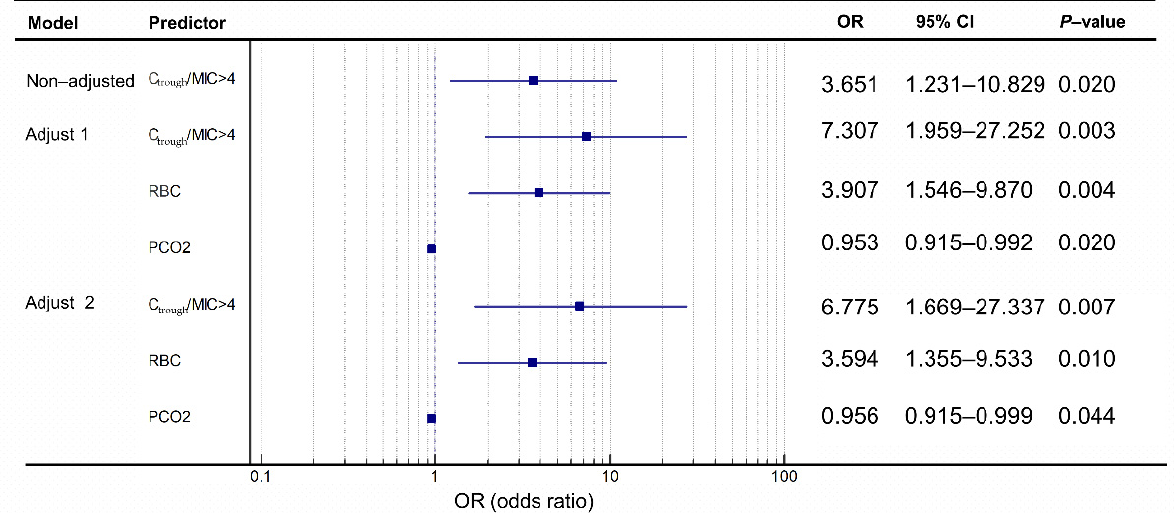
Figure 4. Forest plot of predictors of meropenem treatment success. OR, odds ratio; RBC, red blood cells; PCO 2 , arterial partial carbon dioxide pressure. Model 1: adjusted for RBC and PCO 2 ; model 2: adjusted for RBC, PCO 2 , albumin, CRP, and total bile acid.